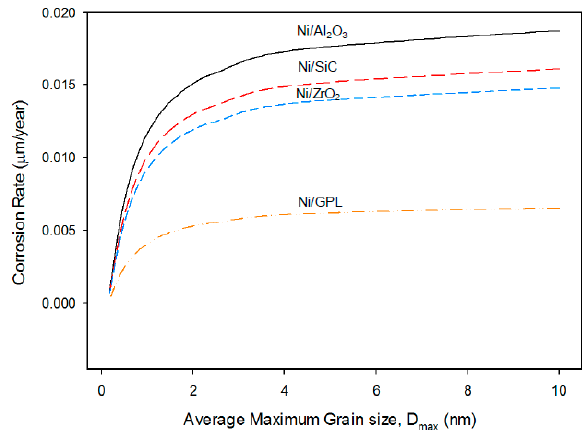
Figure 9. The corrosion rates of coatings as a function of average maximum grain size.